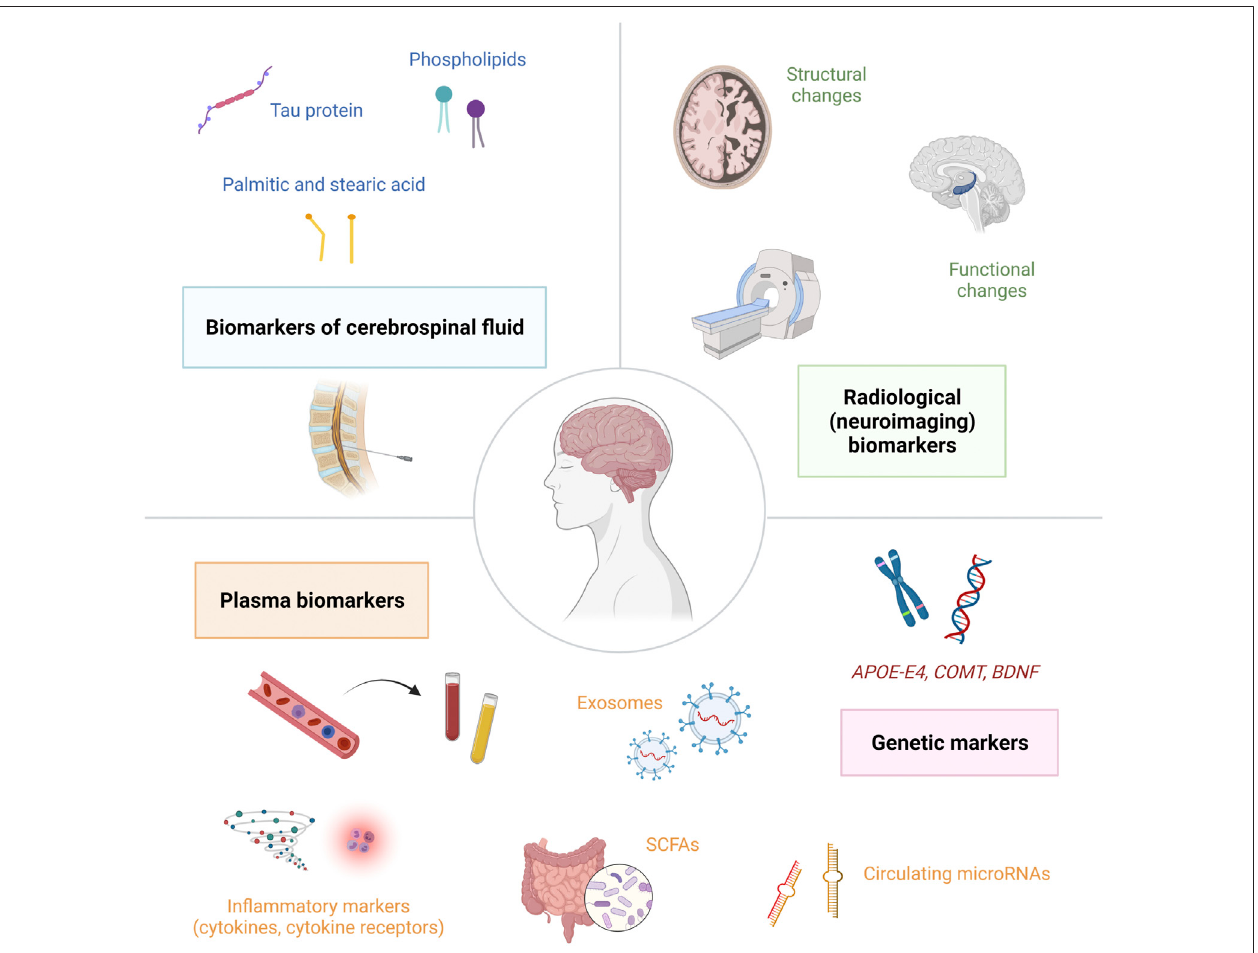
FIGURE 3 | Biomarkers of cognitive dysfunction in cancer patients can be divided into several categories: genetic biomarkers, plasma biomarkers, biomarkers of cerebrospinal fl uid and radiological (neuroimaging) biomarkers.; Abbreviations: APOE-E4 (cid:1) apolipoprotein E4; BDNF (cid:1) brain-derived neurotrophic factor; COMT (cid:1) catechol-O-methyltransferase; SCFAs (cid:1) short-chain fatty acids.